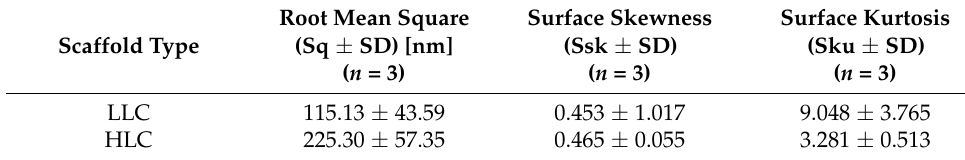
Table 9. Amplitude roughness parameters of nanosurface topography: Root-mean-square deviation of the surface (Sq), skewness of surface height distribution (Ssk), and kurtosis of surface height distribution